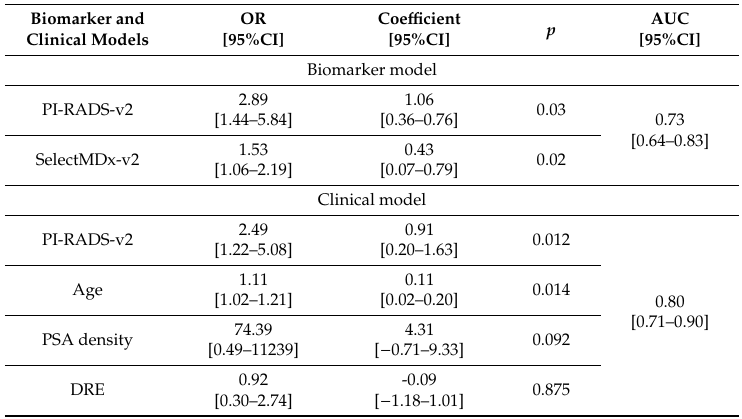
Table 2. Logistic regression of biomarker and clinical models. Odds ratios and regression coe ffi cients are presented for each variable surviving parameter selection after incorporation into the final multivariable model. 95% CI: 95% confidence interval.